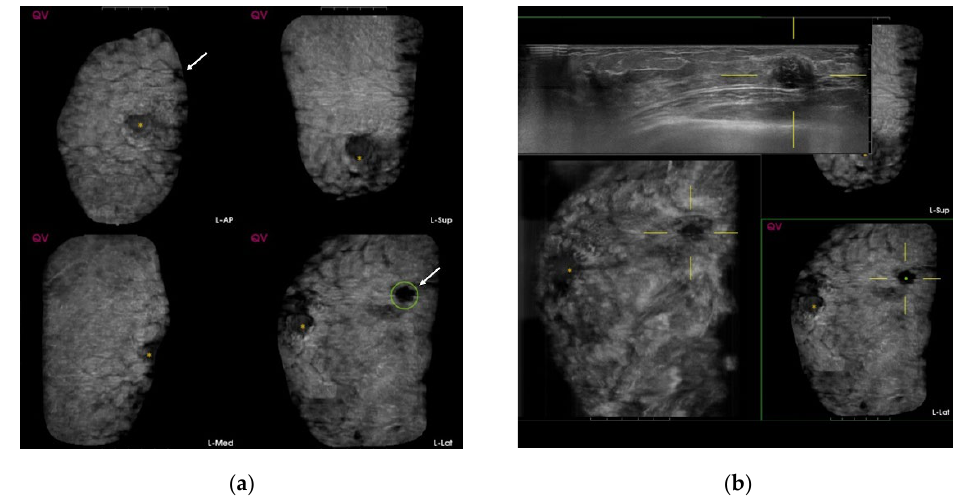
Figure 1. Screening automated breast ultrasound (ABUS) of a 44-year-old woman shows a true- positive mark. ( a ) Computer-aided detection (CAD)-based minimum intensity projection (MinIP) of an ABUS scan of the antero-posterior (AP), medial, and lateral sides of the left breast. There is one dark spot (arrows) with a green circle. ( b ) The lesion showing a dark spot with a green circle laterally on the left breast confirms invasive ductal carcinoma.